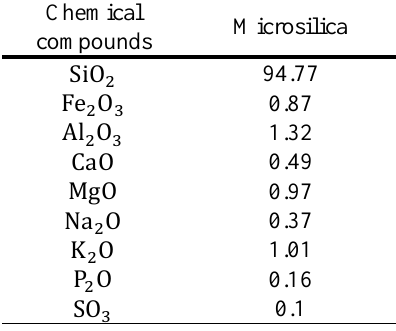
Table 5. Chemical properties of microsilica used in this dissertation